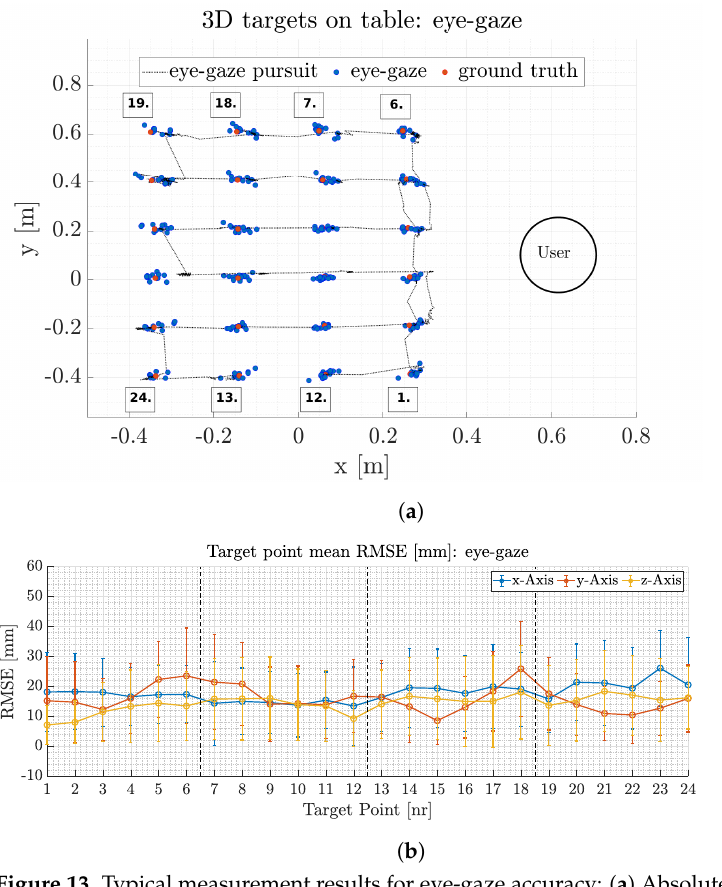
Figure 13. Typical measurement results for eye-gaze accuracy: ( a ) Absolute position of head-gaze on target position. The ground truth position of the targets (red circles) is based on pre-recorded Qualisys measurements. Absolute eye-gaze position on a target are depicted as blue circles. A sequence of one complete transition between targets through eye-gaze is depicted as a dotted black line. The users approximate position is represented as a black circle. Figure ( b ) depicts the mean error of the eye-gaze for each individual axis along target points throughout all trials. The black dashed lines indicate separation of the target groups for all four